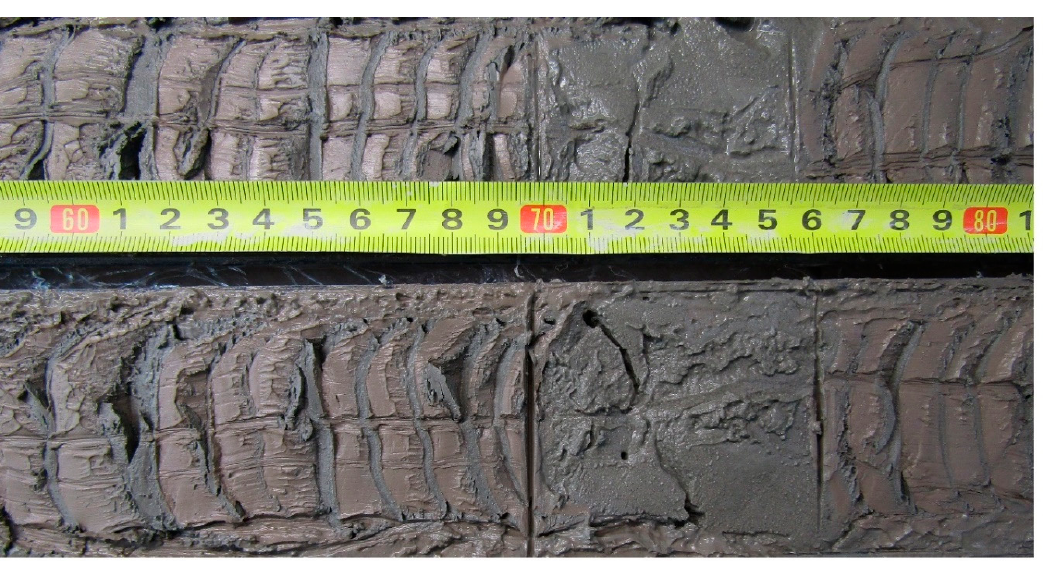
Figure 7. Typical varved clays with graded layering. Lithological unit 4, core ONG-5. Lithological unit 5. Sandy clays or clayey sands with thickness up to 1 m. Gray, non-laminated, with coarse sand and pebbles. This unit was identified only in the Petrozavodsk Bay.